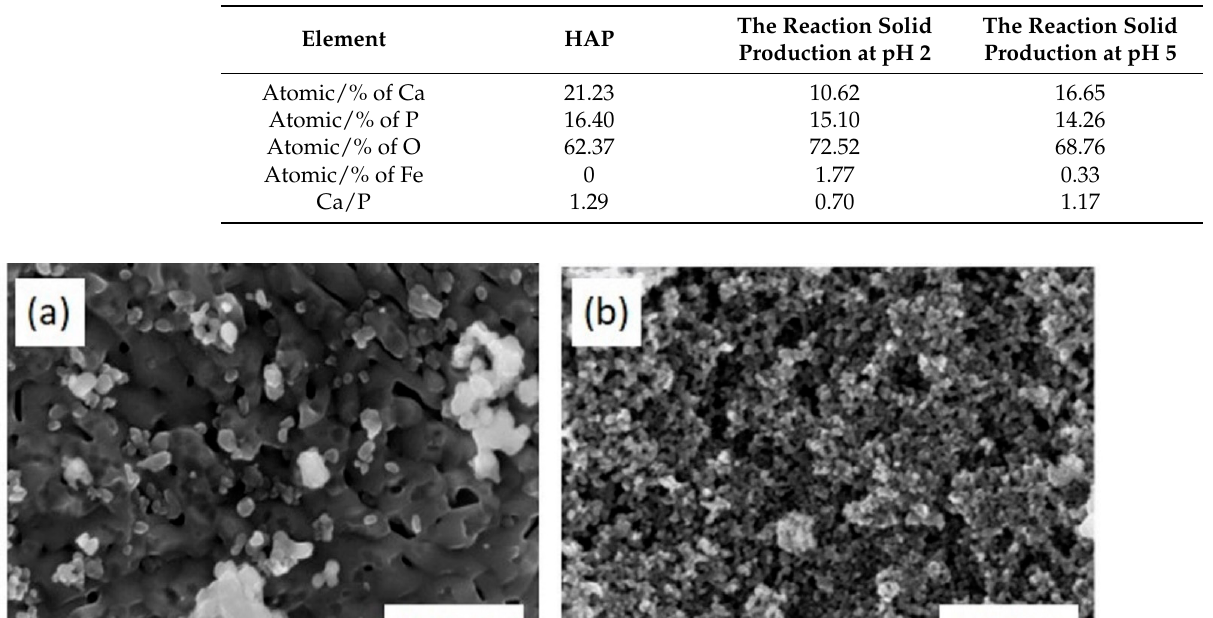
Table 1. Element distribution and the Ca to P ratio in the presence of HAP.